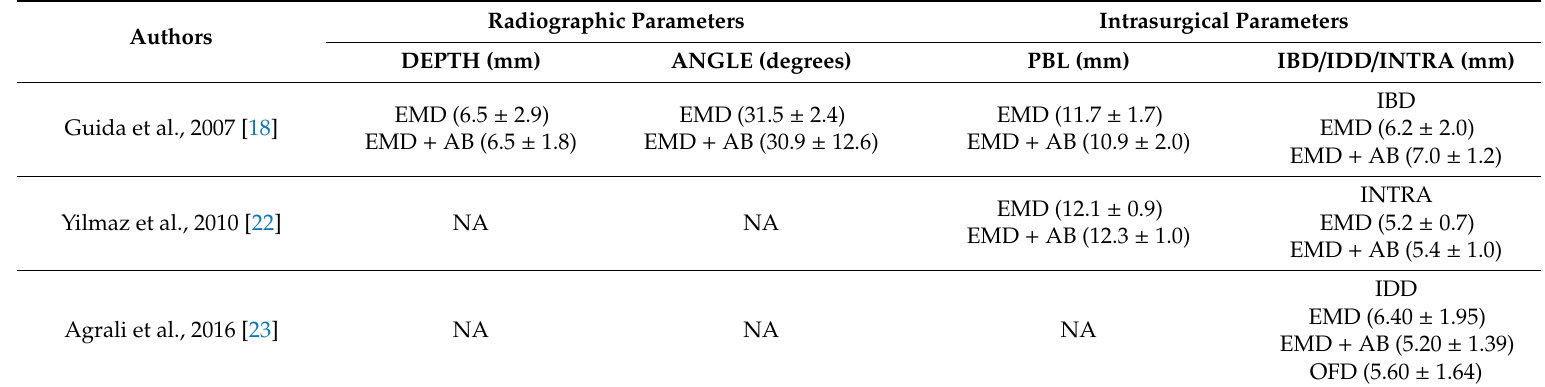
Table 6. Radiographic and intrasurgical characteristics of intrabony defects at